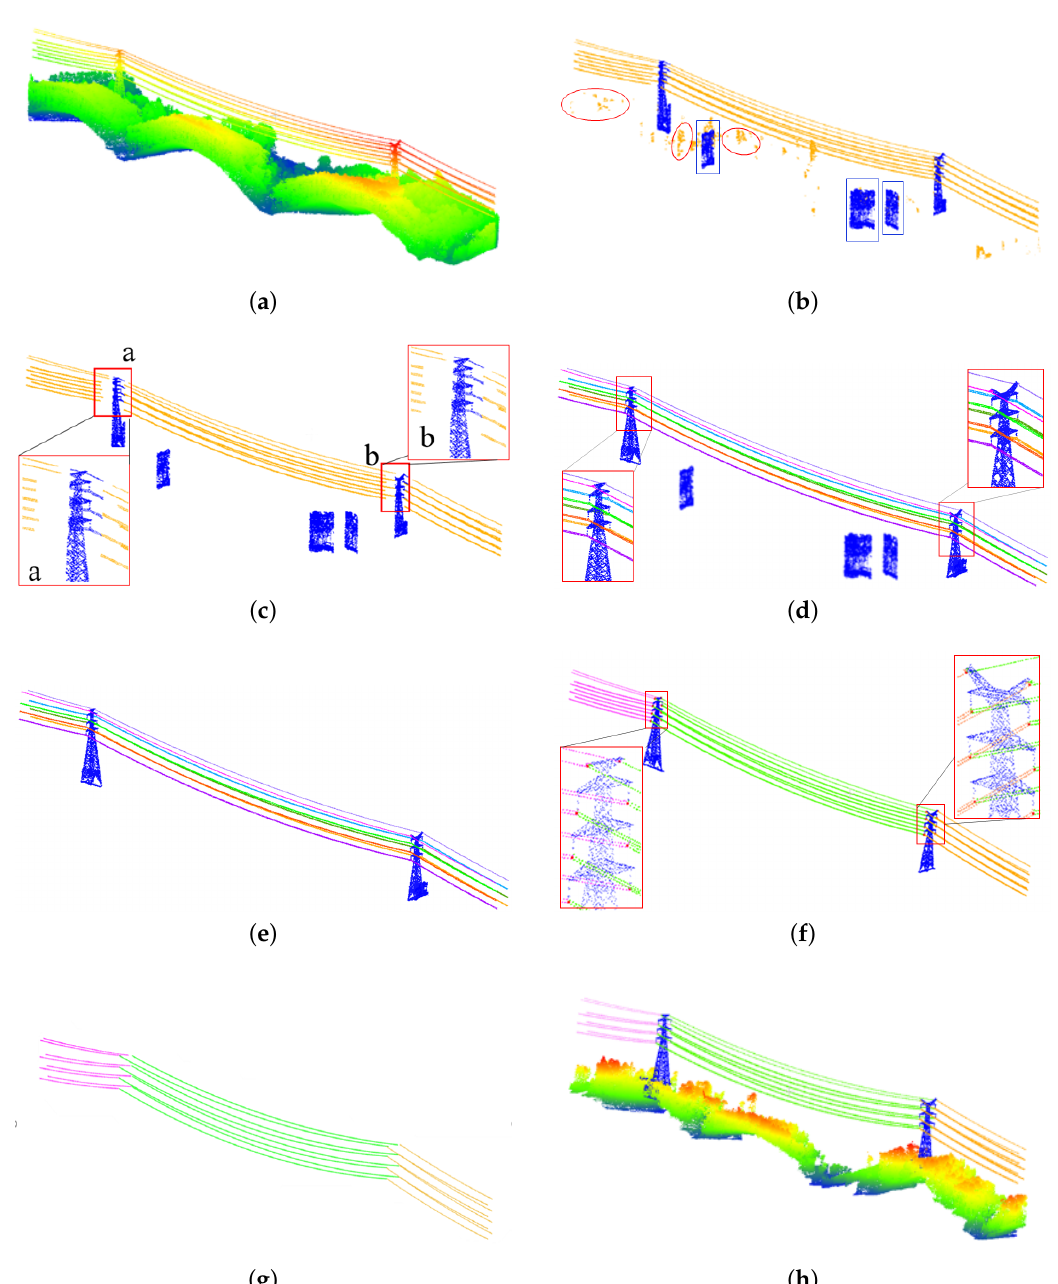
Figure 15. The process of a typical scene of 220 kV power lines. ( a ) The original scene of the power lines rendering according to the elevation. ( b ) The coarse extraction result. ( c ) The result of removing false positive power line points. ( d ) The completed result of the missing power line points. ( e ) The result of removing the false positive pylons. ( f ) The extraction result of the suspension points and the segmentation result of power lines. ( g ) The fitting result of the conductors. ( h ) The result of the safety distance of the ground